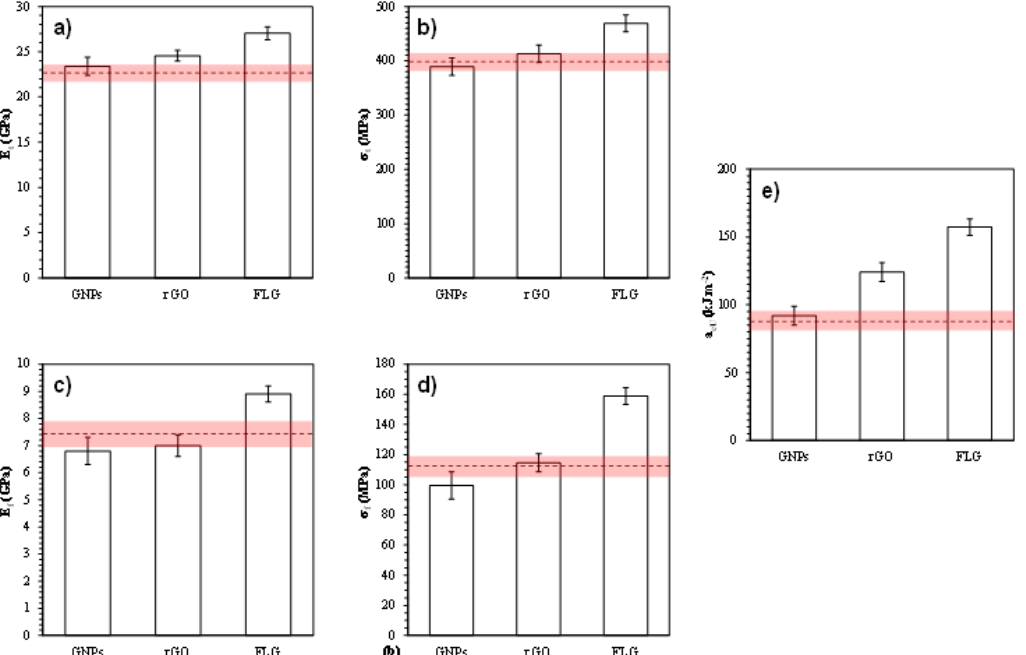
Figure 6. Mechanical properties of the tested laminated plates: ( a ) Tensile modulus (E t ); ( b ) Ultimate tensile strength ( σ t ); ( c ) Flexural modulus (E f ); ( d ) Ultimate flexural strength ( σ f ); ( e ) Charpy impact strength (a cU ). The dashed line represents the mean value obtained for an undoped UATR/Aramid composite with its corresponding error interval (light red band).